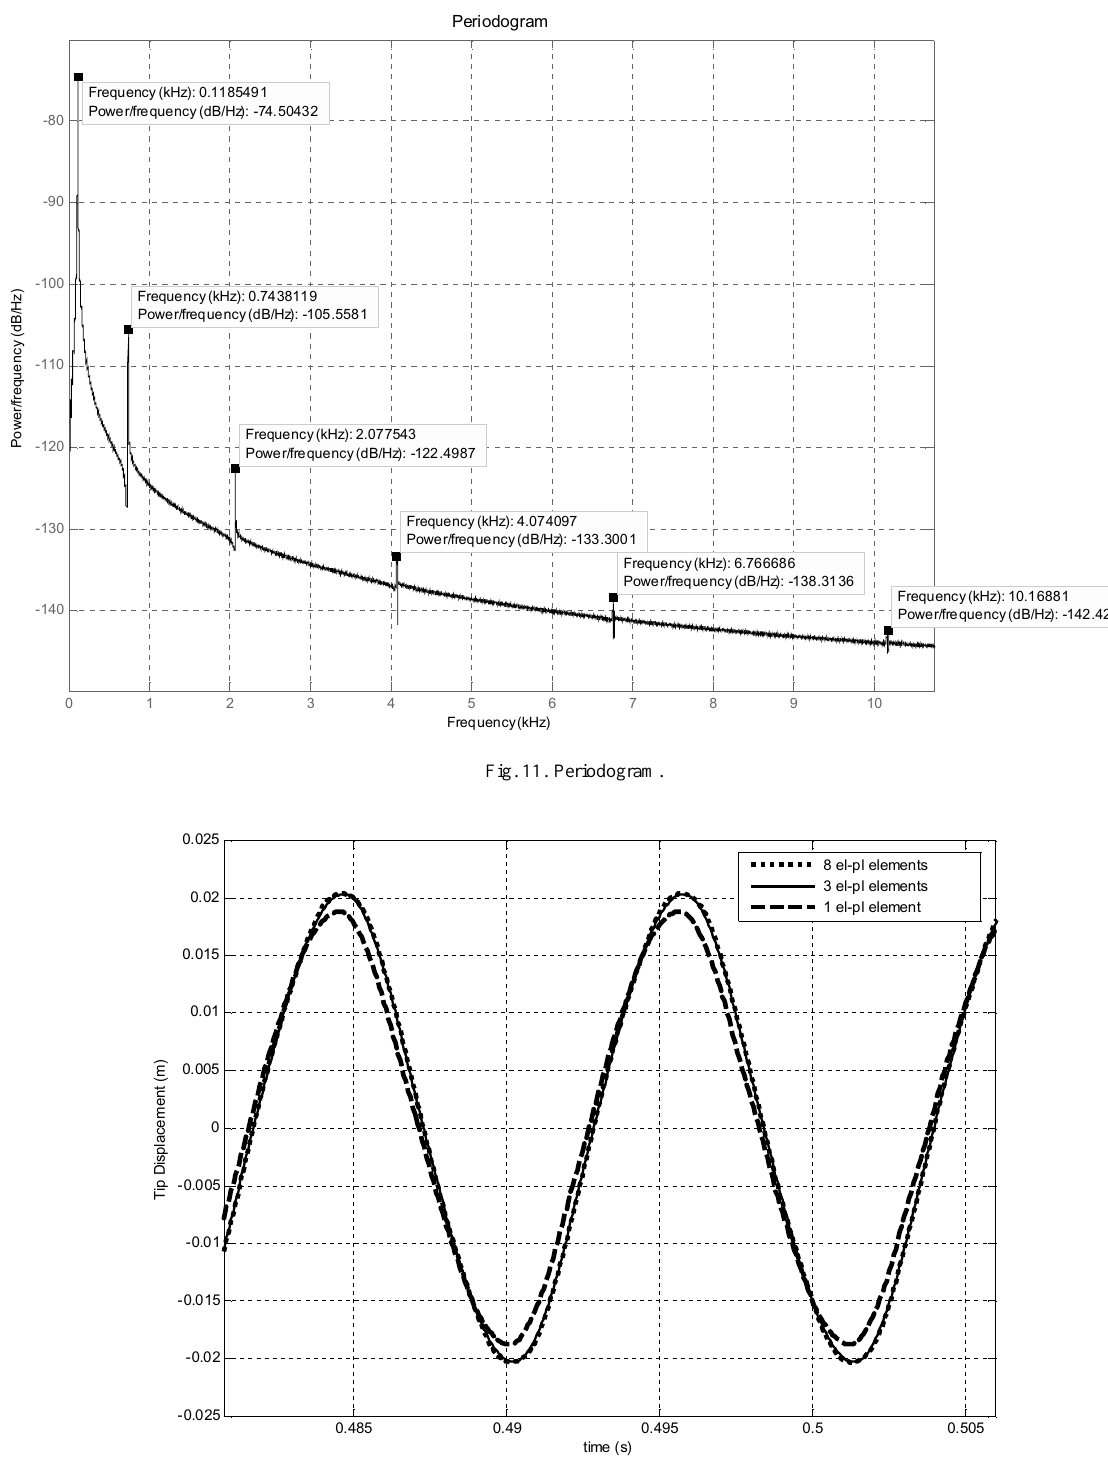
Fig. 12. Tip displacement with respect of